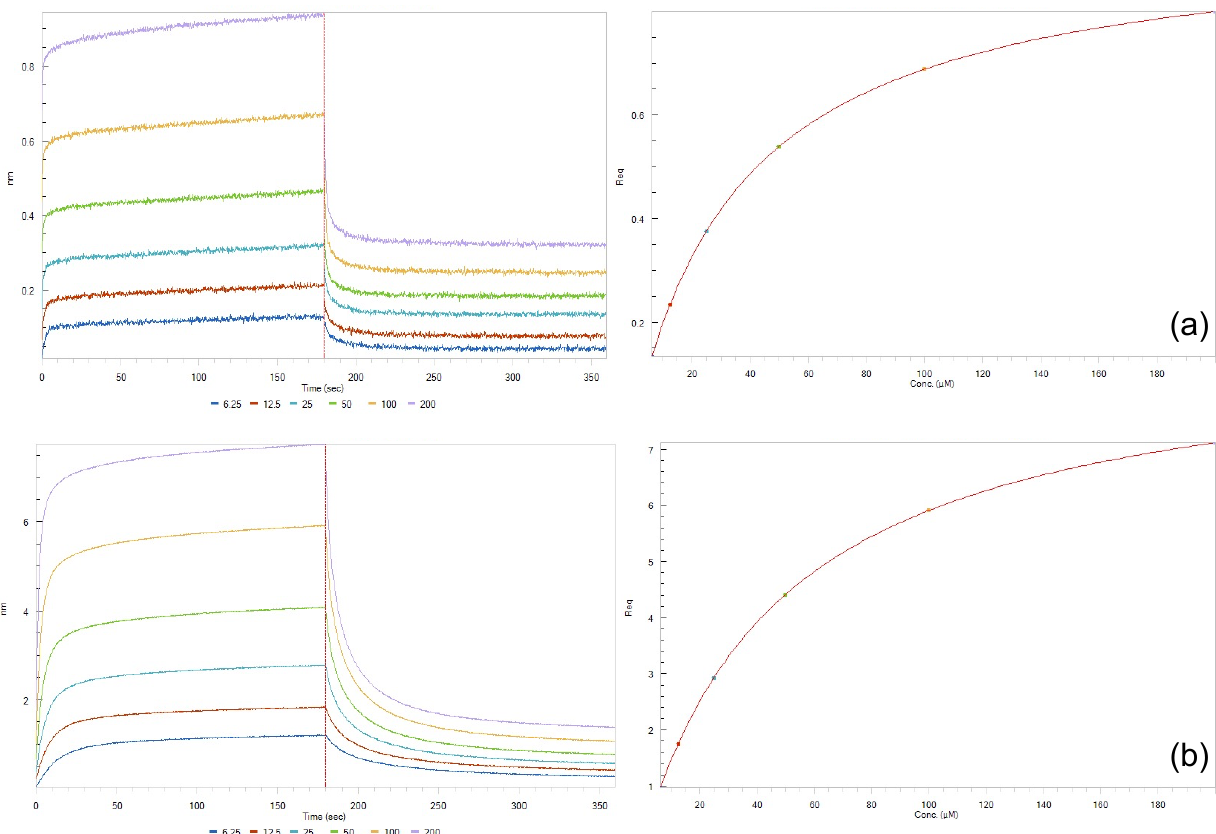
(Figure 6) and that artemisone is a good binder for the RBD.